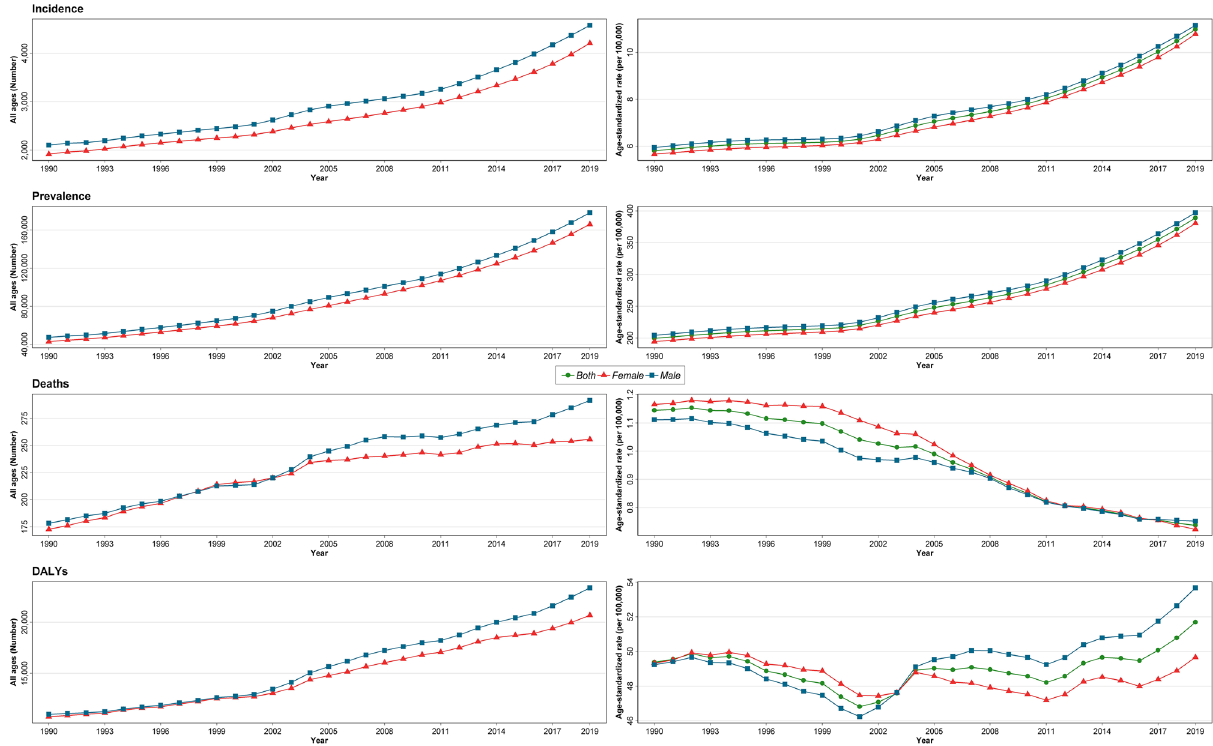
Figure 1. Time trend of T1DM burden by all ages number and age-standardized rate by sex in the country from 1990 to